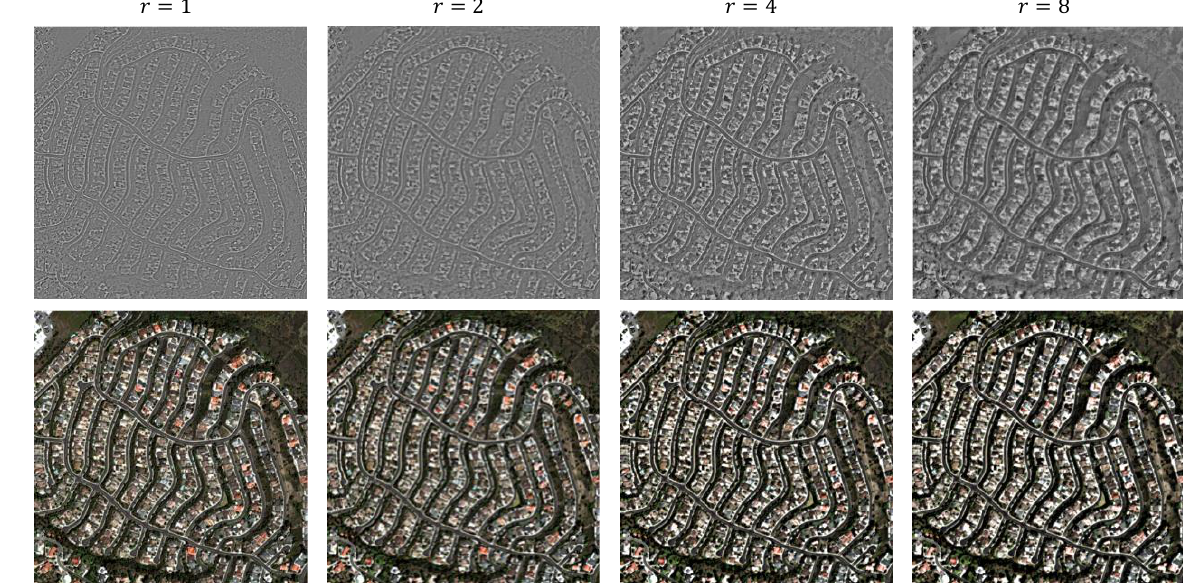
Figure 11. The influence of different values of window radius on DCGIF model. Table 2. Objective evaluation of DCGIF filtering results with different window